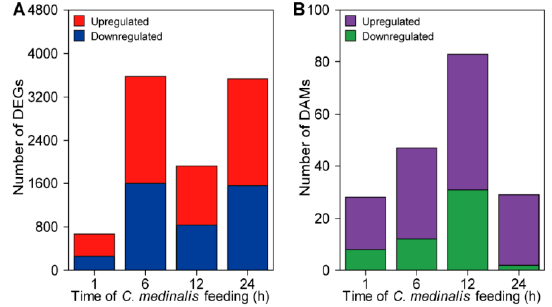
Figure 3. Numbers of ( A ) differentially expressed genes (DEGs) and ( B ) differentially accumulated metabolites (DAMs) that are up- and downregulated in rice leaves damaged by C. medinalis at different time points compared to undamaged control plants.